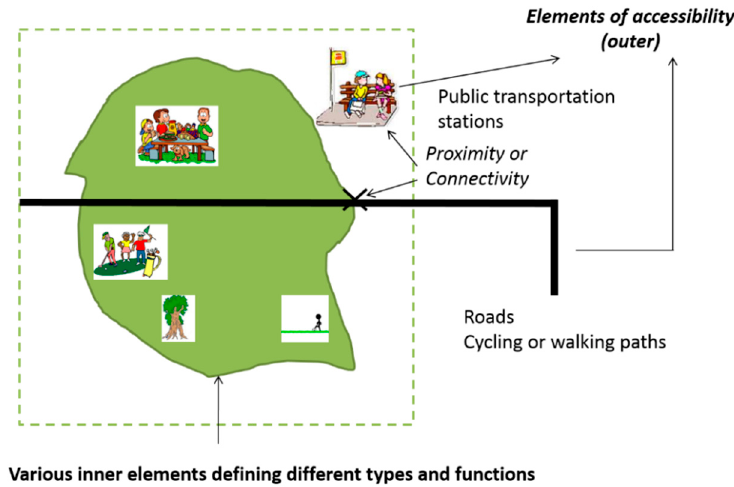
Figure 1. A conceptual framework for linking green space typology and accessibility.